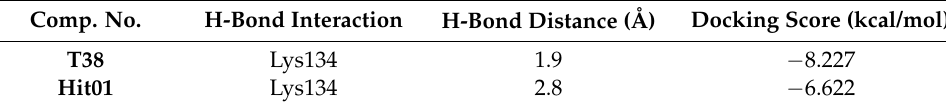
N endonuclease protein (PDB ID 6E6W).